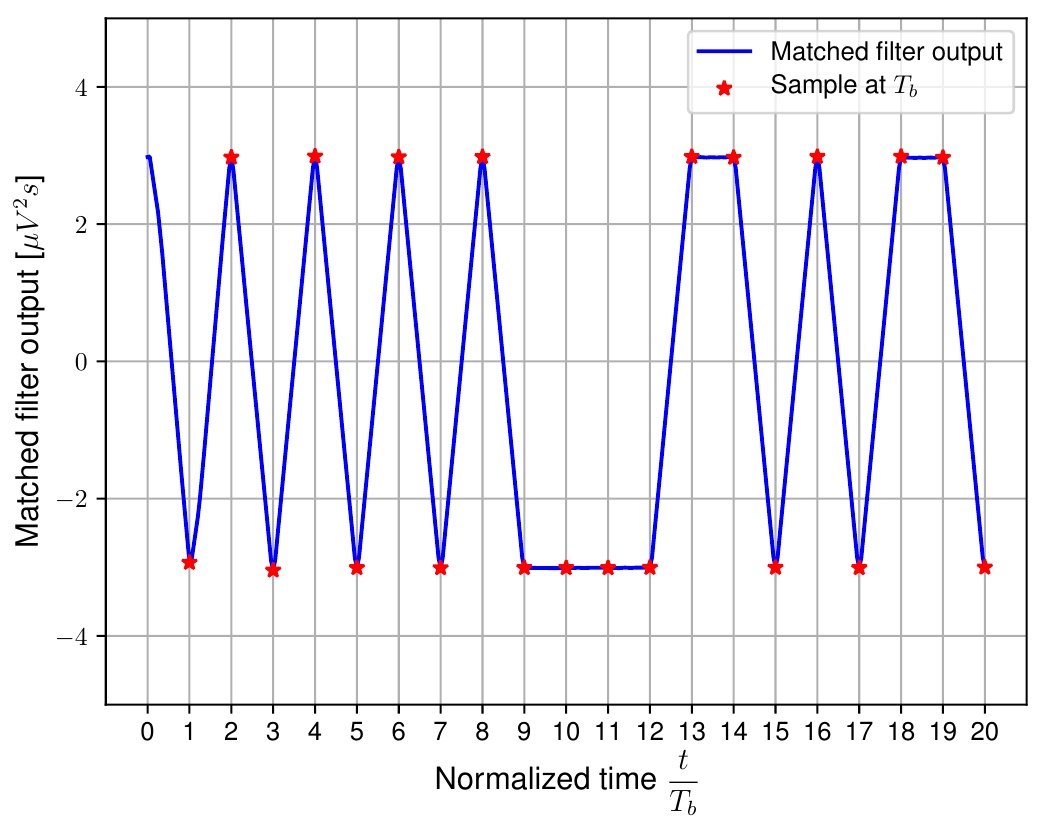
Figure 9. Illustration of the matched filter output for T b = 250 µ s and θ = 0 ◦ using setup A